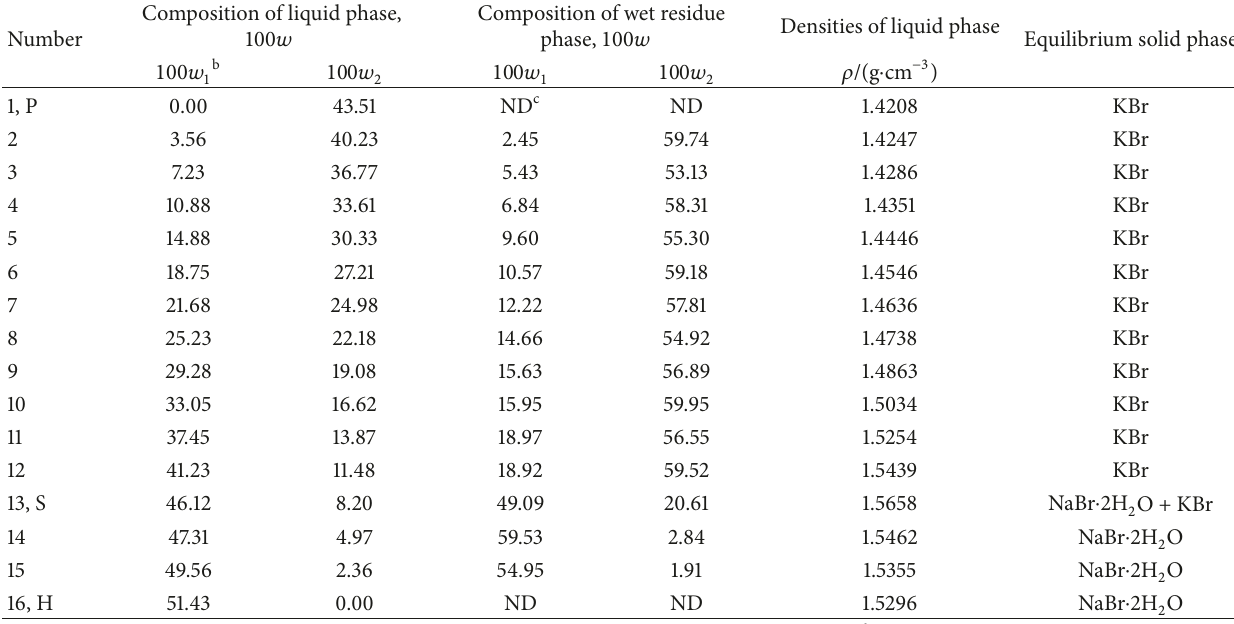
Table 2: Mass Fraction Solubility of the ternary NaBr + KBr + H 2 O system at temperature = 313.15K and pressure = 0.1 MPa a . Composition of liquid phase, Composition of wet residue Densities of liquid phase 100𝑤 Number phase, 100𝑤 Equilibrium solid